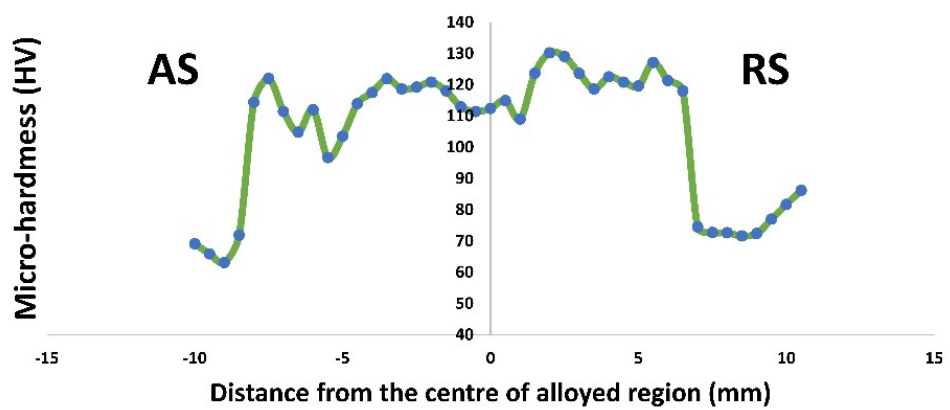
Figure 8. Microhardness distribution across the transverse section of the alloyed